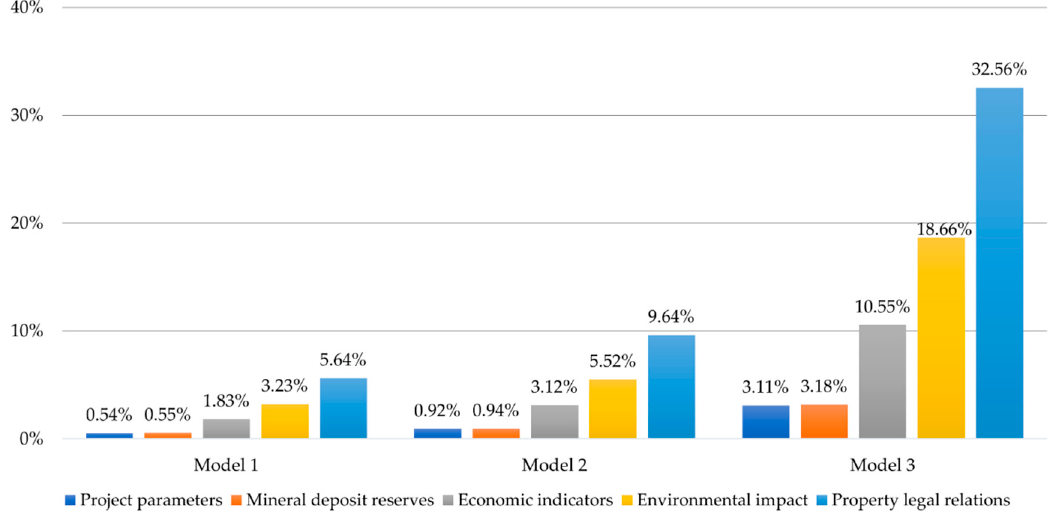
Figure 6. The structure of main groups of criteria for each model.